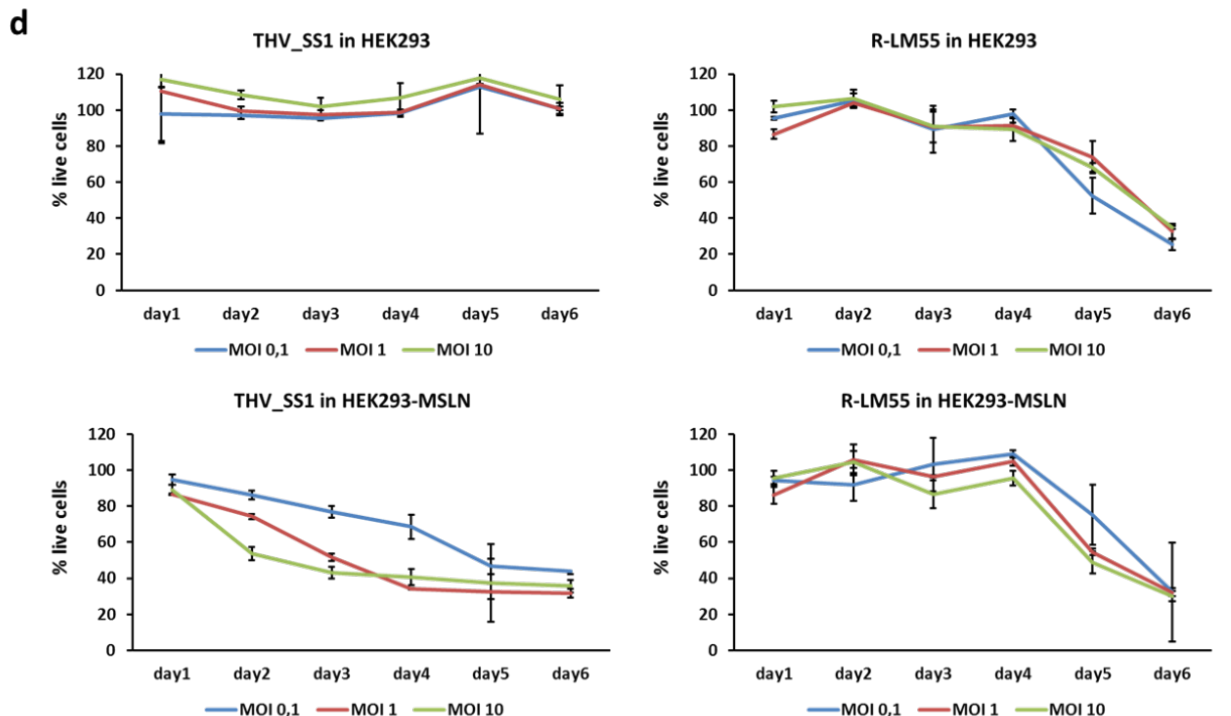
Figure 3. Cytopathic effect of THV_SS1 is tightly dependent on MSLN positive cells. ( a ) HEK293 cells (MSLN-) were infected from wild-type virus R-LM55, but not from THV_SS1 virus, confirming the stringency of the retargeting. ( b ) HEK293 cells were stably transduced with mesothelin protein and were efficiently infected (fluorescent positive cells) at different MOI s (MOI from 0.001 to 1) by THV_SS1, up to 120 h post-infection. Bright-field images show the cytotoxic effect of THV_SS1 virus (round detached cells). ( c ) Mesothelin retargeting does not impact on viral replication in proficient cells, as THV_SS1 and parental R-LM55 viruses replicate equally well in HEK293-MSLN cell line. ( d ) The cytotoxic effect of R-LM55 and THV_SS1 in HEK293 and HEK293-MSLN was assessed by Alamar Blue. After 6 days from infection, R-LM55 reached 70% of cytopathic effect in both HEK293 cells (+/ − MSLN), while THV_SS1 reached 70% of cytopathic infect only in HEK293-MSLN and maintains 100% of live cells in wild-type HEK293 cells.